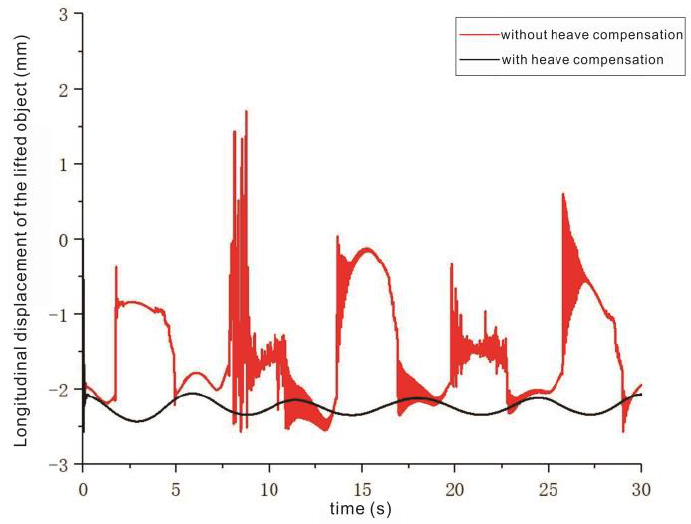
Figure 9. Displacement diagram of the platform electric cylinder.